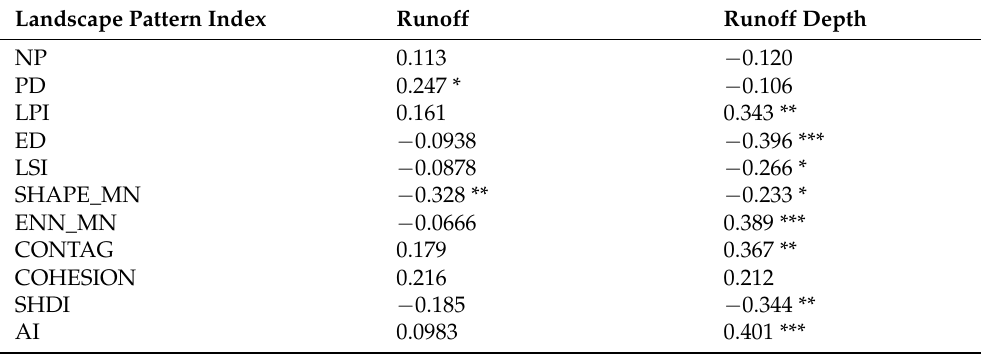
Table 2. Pearson correlation coefficients between runoff and runoff depth as well as landscape indexes. Landscape Pattern